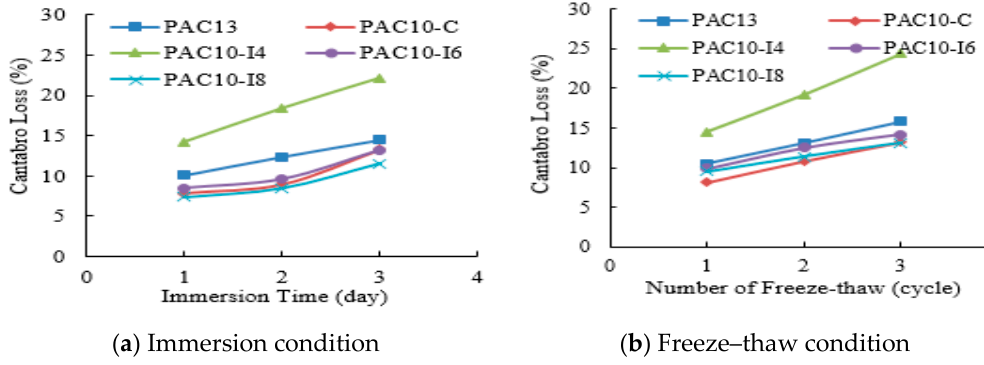
Figure 6. Cantabro losses of PAC mixtures.